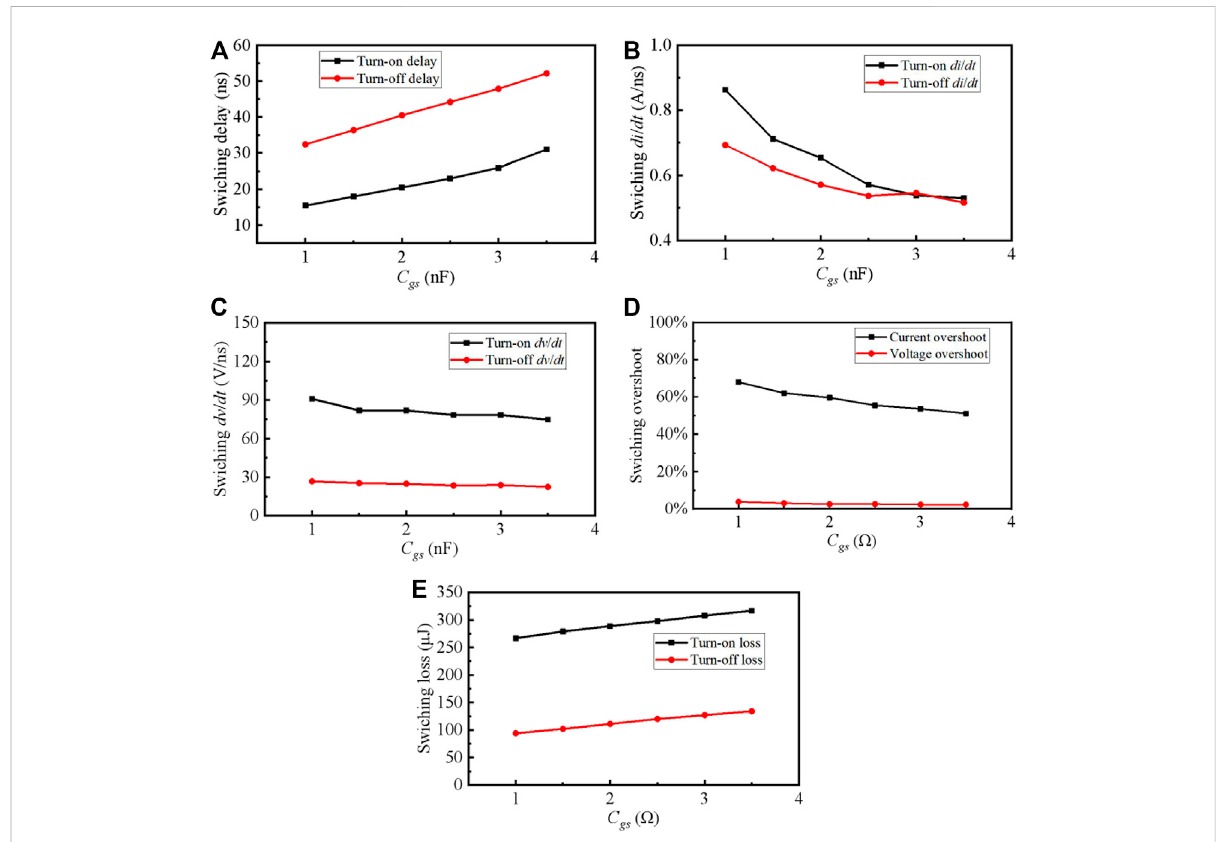
FIGURE 7 Dynamic characteristics of the SiC MOSFET with different C gs . (A) Switching delay. (B) Switching di/dt. (C) Switching du/dt. (D) Switching overshoot. (E) Switching loss.